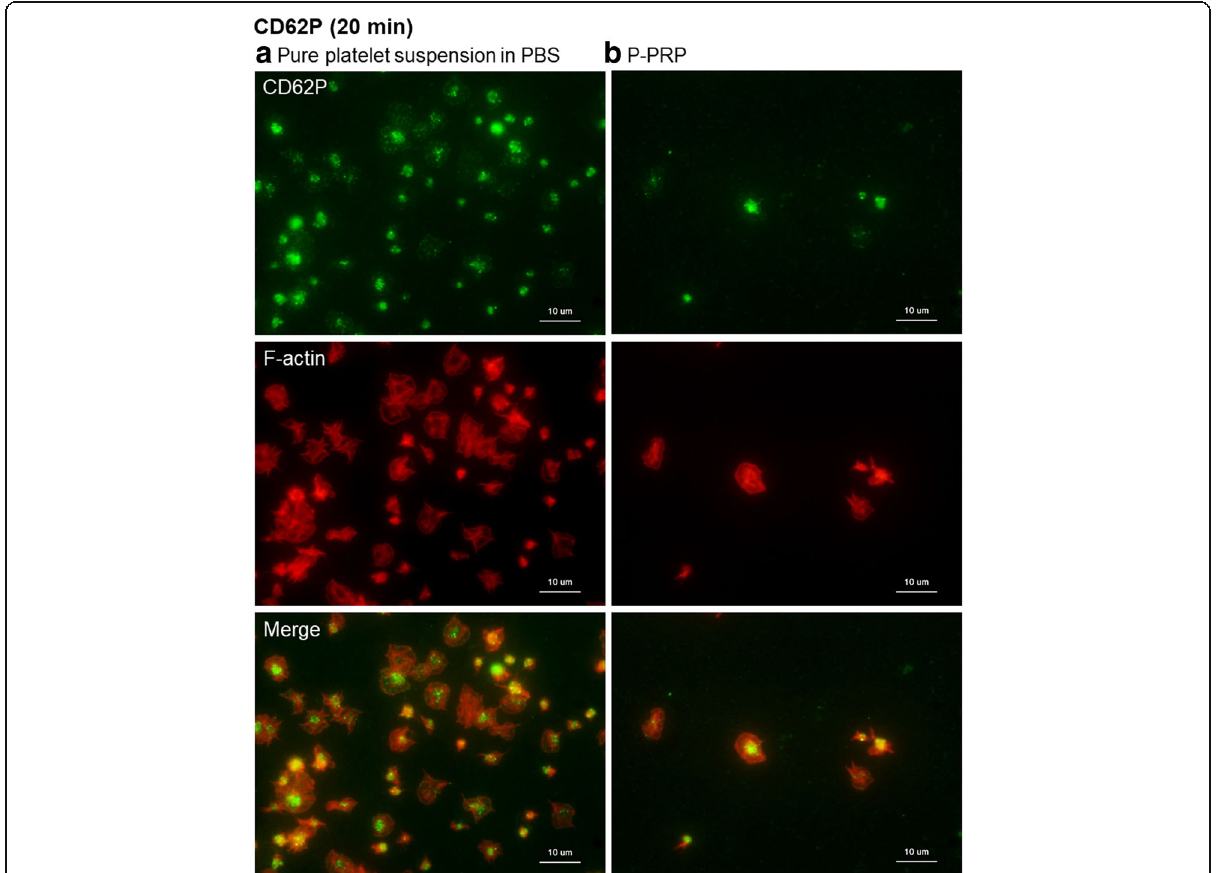
Fig. 9 Expression of CD62P in platelets adhered onto the surface of cp -Ti plates. a Platelets suspended in PBS and b P-PRP. CD62P (green) and F-actin (red) were individually visualized and merged in the bottom panels. cp - Ti commercially pure titanium, PBS phosphate-buffered saline, P - PRP pure platelet-rich